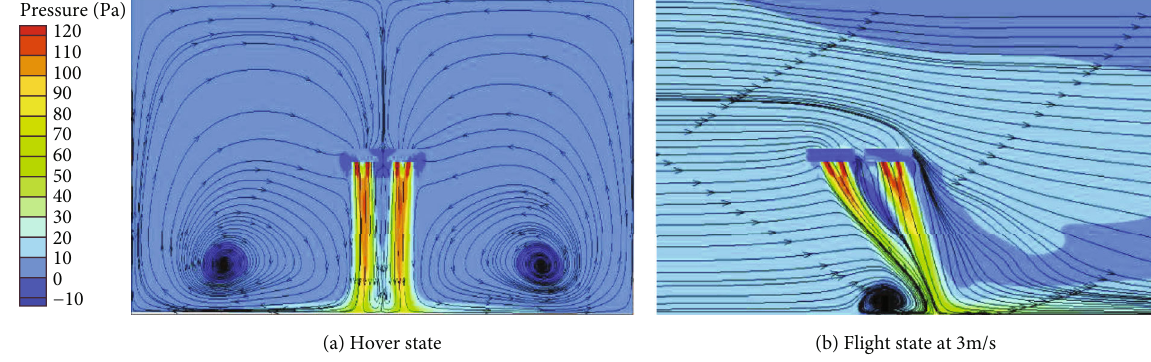
Figure 14: The streamlines of quadrotor fl ow fi